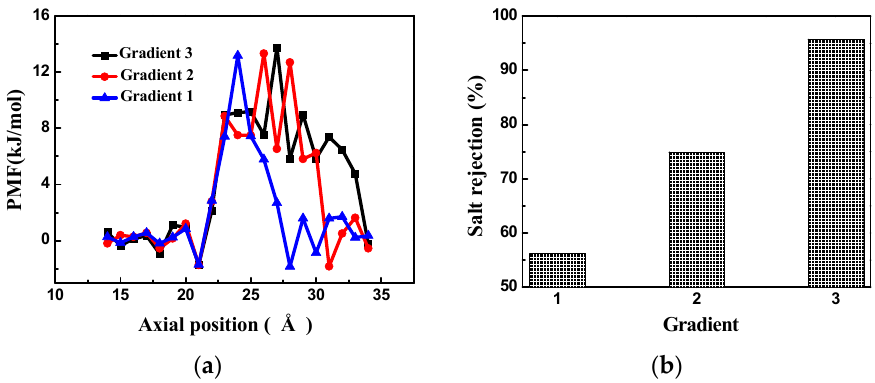
membranes versus time. versus time.